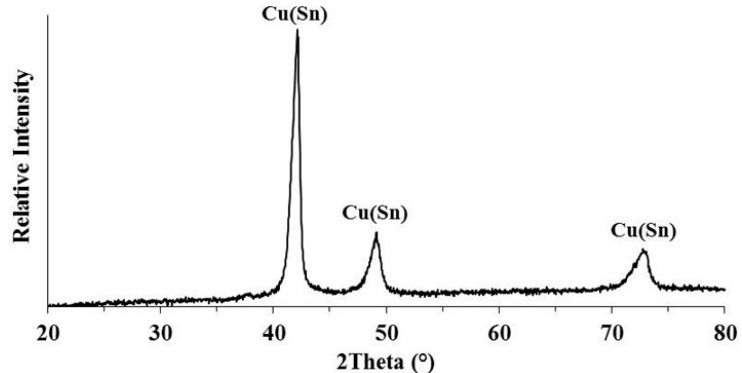
Figure 5. XRD patterns of the cold-sprayed Cu-10Sn coatings.